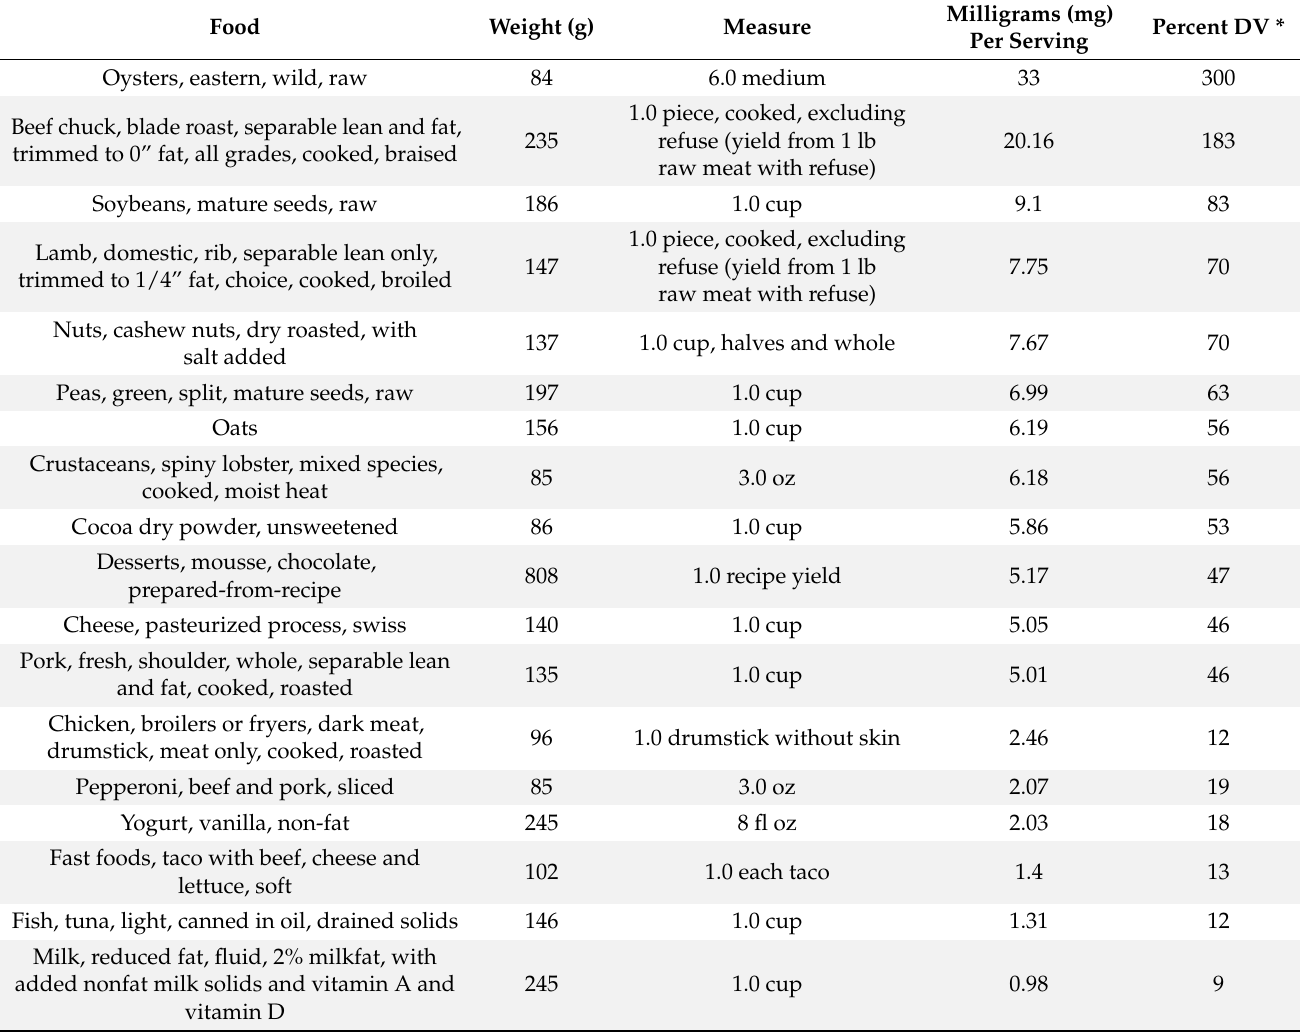
Table 2. Zinc Content and Daily Value of Selected